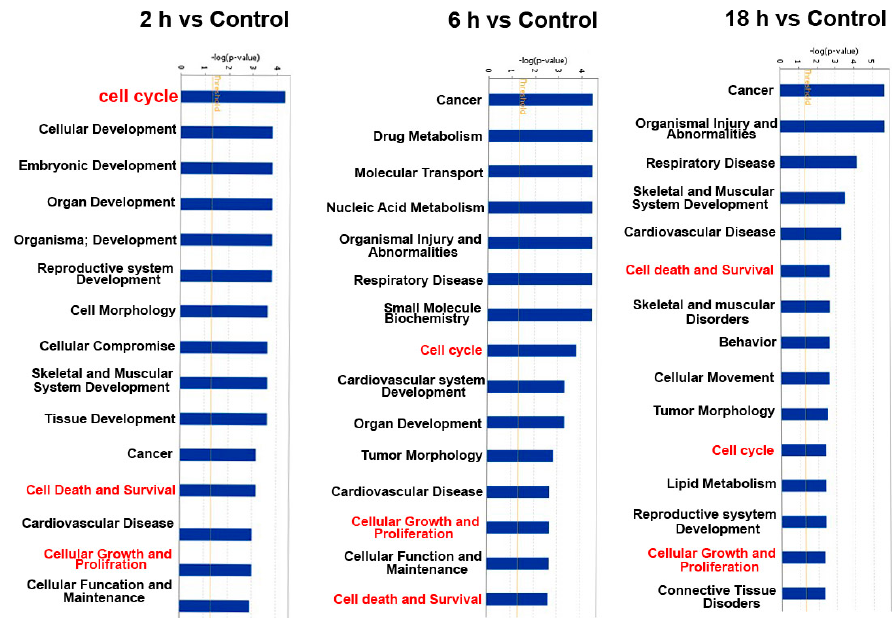
Figure 5. The cellular functions regulated by these 66 differentially expressed miRNAs ( p < 0.05) as analyzed by IPA.